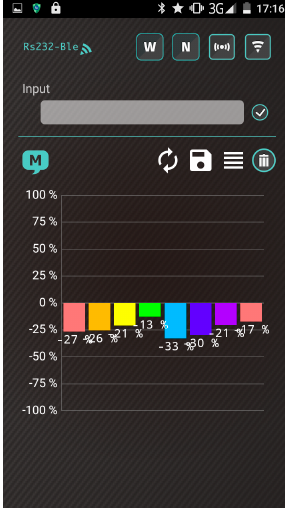
Figure 14. Response of gas sensor array when heated to operating temperature.